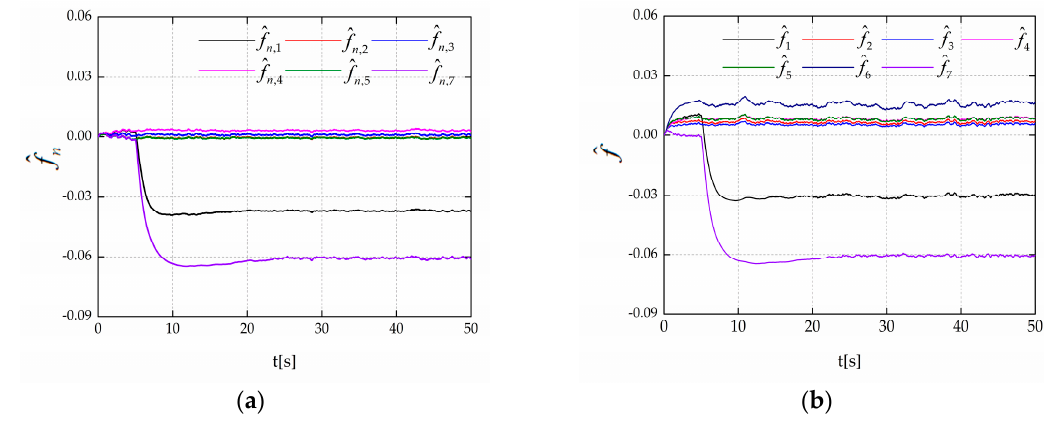
ˆ f ; ( b ) ; n n ˆ f ; ( b ) n